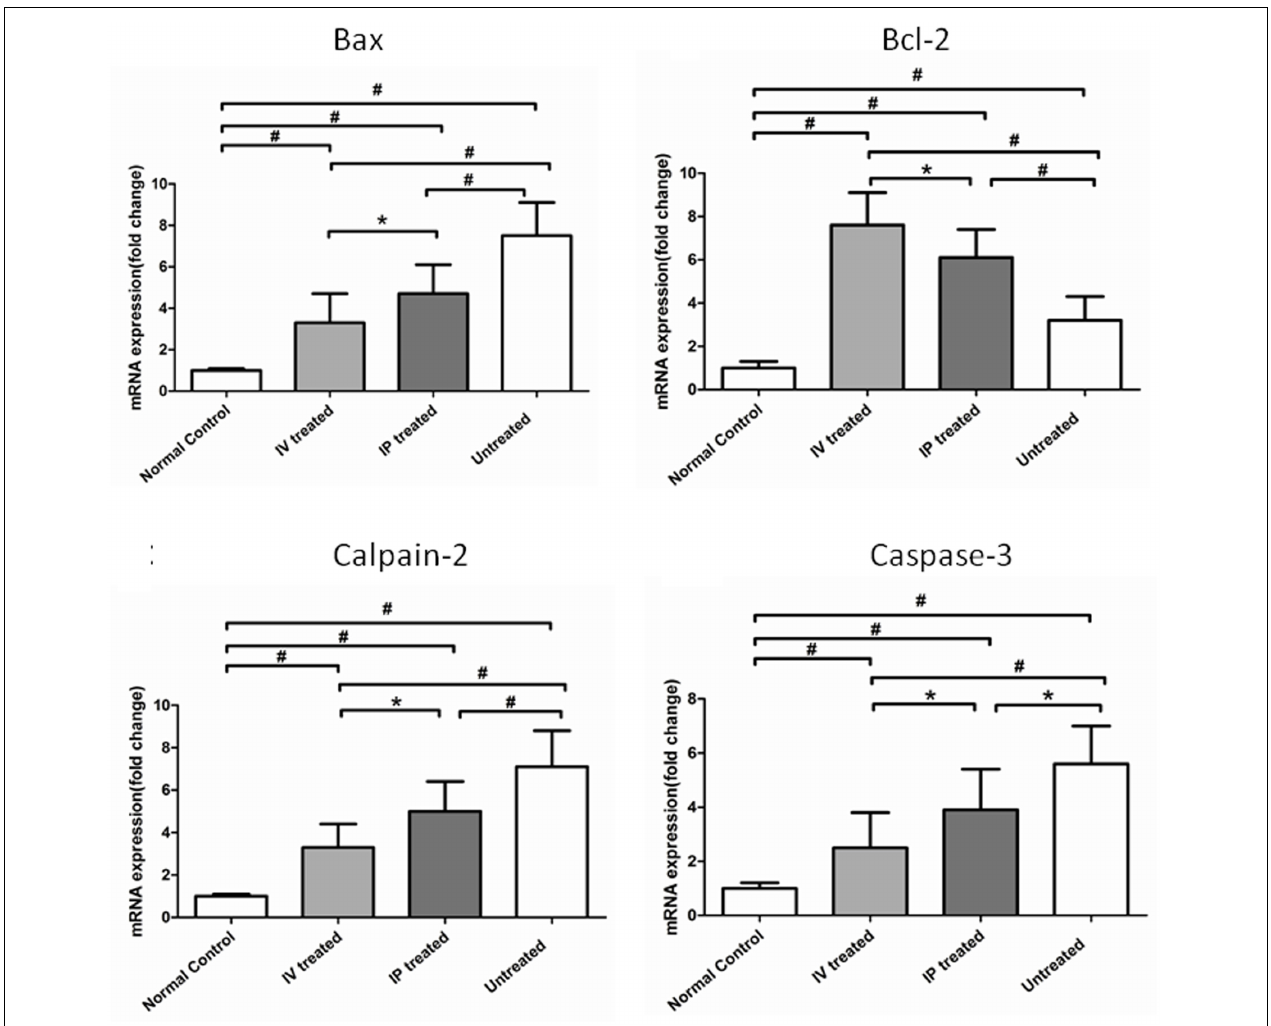
FIGURE 6 | Hydrogen rich saline induced effects on the expression levels of apoptotic-associated genes in MNU administered rats. The expression levels of the apoptotic-associated genes in the untreated group were all up-regulated compared with normal controls ( P < 0.01). In both IV and IP treated groups, the expression levels of Bax and Calpain-2 and Caspase-3 were significantly lower than the untreated group. Conversely, the expression levels of Bcl-2 in both IV and IP treated groups were higher than the untreated group ( P < 0.01). Furthermore, the expression level of Bax and Calpain-2 and Caspase-3 in the IV treated group were significantly lower than the IP treated group ( P < 0.05). The expression level of Bcl-2 in the IP treated group was significantly lower than the IV treated group ( P < 0.05). (All the values were presented as mean ± SD; ∗ P < 0.05, # P < 0.01 for differences compared between the animal